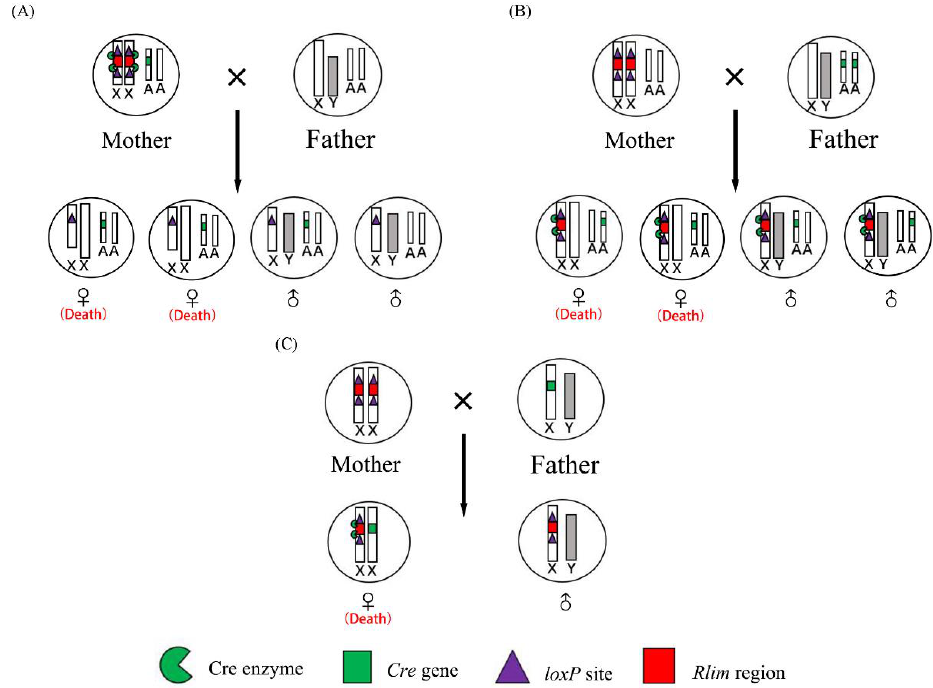
Figure 7. Schematic diagram of three different strategies using the CRE- loxP system to knockout the maternal Rlim gene in female embryos. ( A ) Knockout of the maternal Rlim gene in female embryos by mating wildtype fathers with Rlim fl/fl mothers carrying an autosome-linked Cre transgene driven by an oocyte-specific promoter. ( B ) Knockout of the maternal Rlim gene in female embryos by mating Rlim fl/fl mothers with fathers carrying a Rosa 26 promoter-controlled Cre transgene on autosomes. ( C ) Knockout of the maternal Rlim gene in female embryos by mating Rlim fl/fl mothers with transgenic fathers carrying a CMV-Cre gene integrated on the X chromosome. Knockout of the maternal Rlim gene in male embryos will not affect their